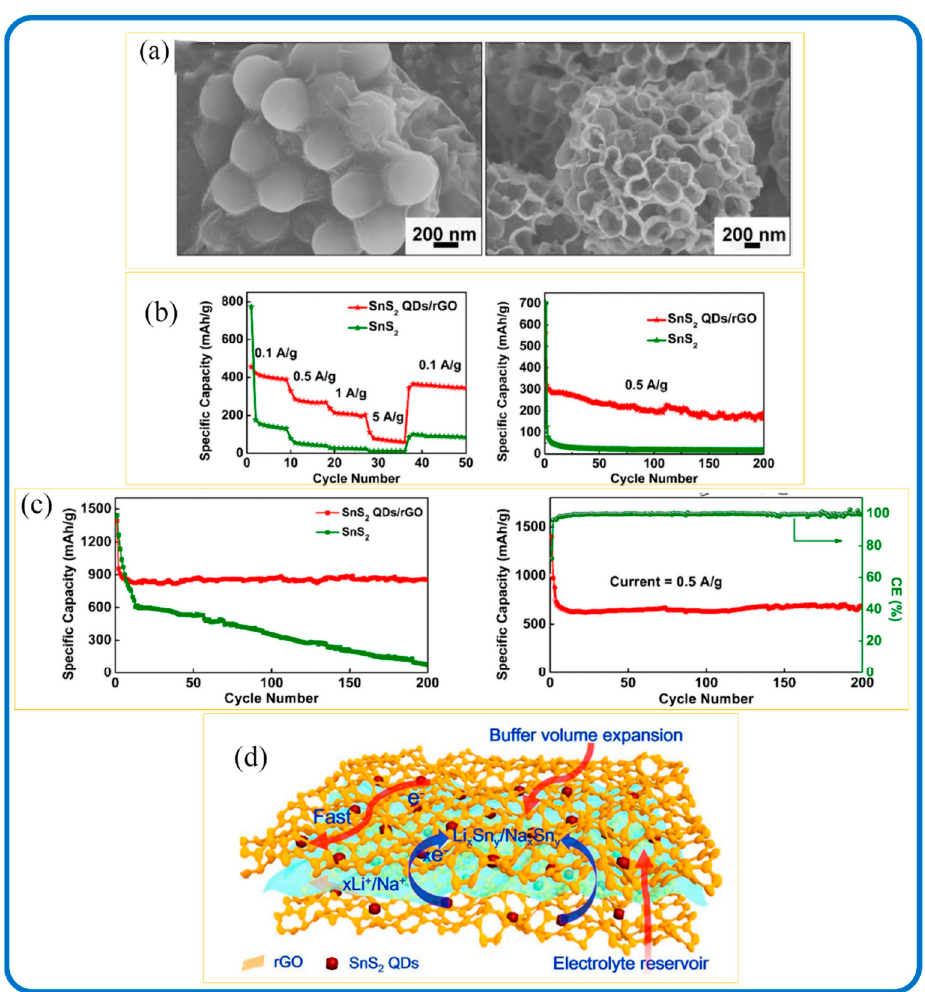
Figure 19. ( a ) SEM image, ( b ) schematic highlights during the charge/discharge processes of the 3D SnS 2 QDs/rGO composite, ( c ) LIBs, ( d ) SIB performance of the SnS 2 and 3D SnS 2 QDs/rGO composite. Adapted from [243] . Copyright 2019, Springer, Open Access .